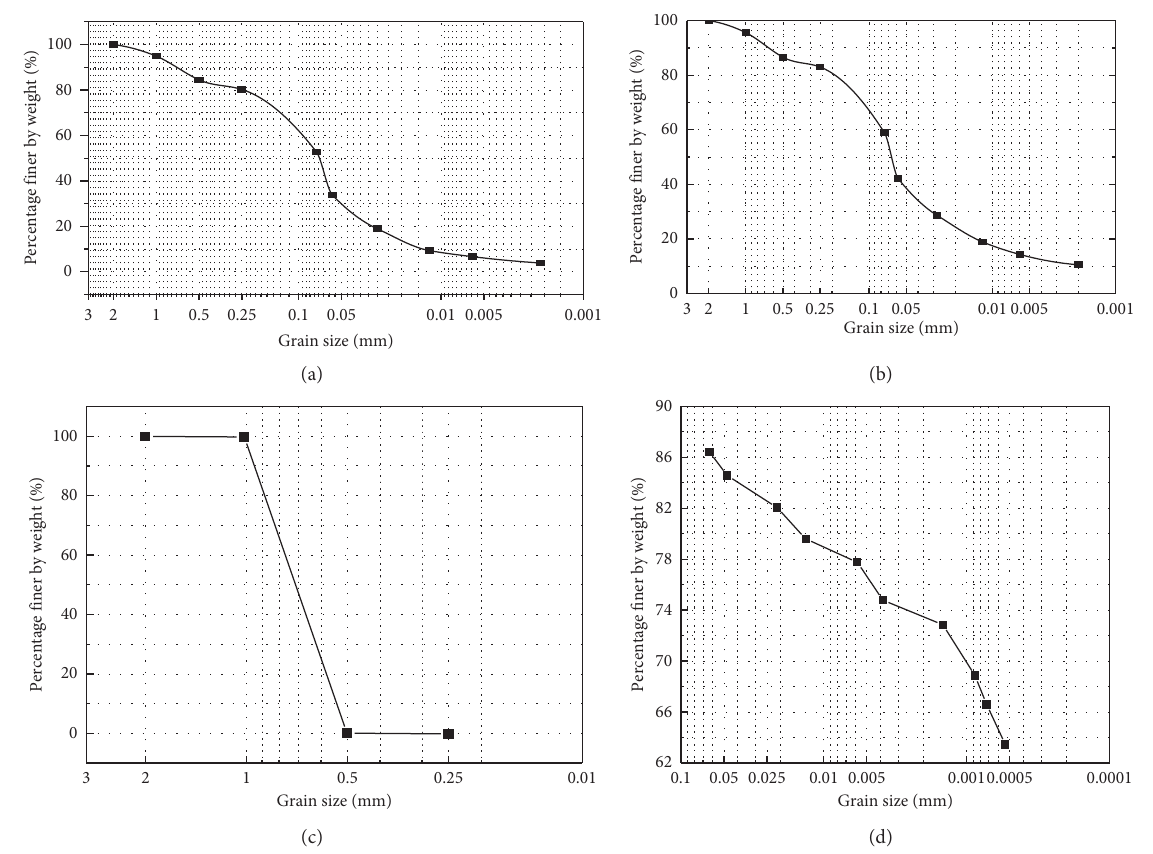
Figure 1: Grain size distribution of the different soil types. (a) SSH. (b) SSL. (c) Calcareous sand. (d) Red